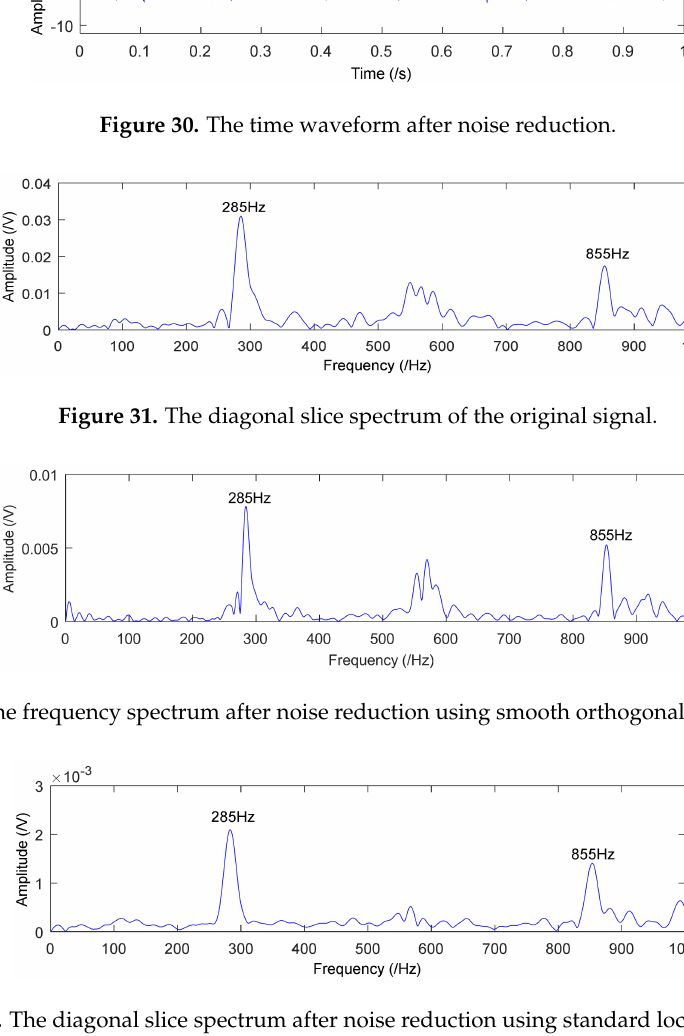
Figure 33. The diagonal slice spectrum after noise reduction using standard local projection.